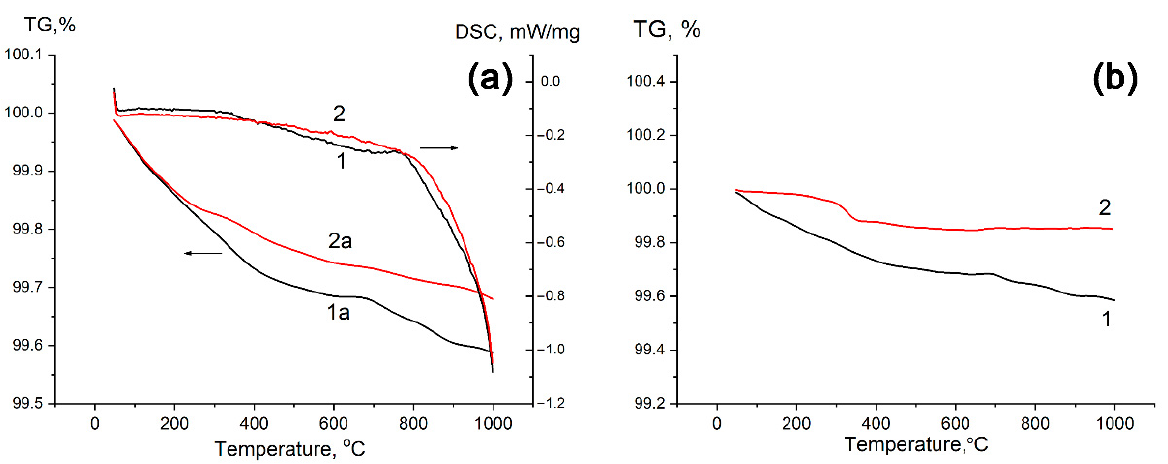
Figure 4. ( a ) DSC curves (1—first heating; 2—second heating) and TG curves (1a—first heating; 2a—second heating) of the powder sample La 2 (Hf 1.9 La 0.1 )O 6.95 (left arrow—TG axis , right ar- row—DSC axis); ( b ) TG curves: (1) first heating of La 2 (Hf 1.9 La 0.1 )O 6.95 and (2) La 2 Hf 2 O 7 powder sample.